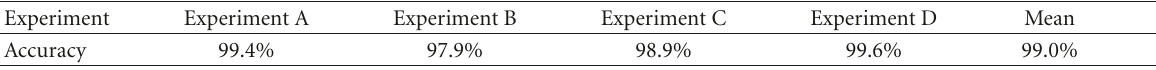
Figure 12: Construction of feature vector in the second scale (medium-size vessels), the horizontal axis, shows the position of vessels (in degrees) in polar coordinates and the vertical axis and shows the angle (in degrees) between corresponding vessel orientation and the horizontal axis in the polar image. Table 1: Experimental results.